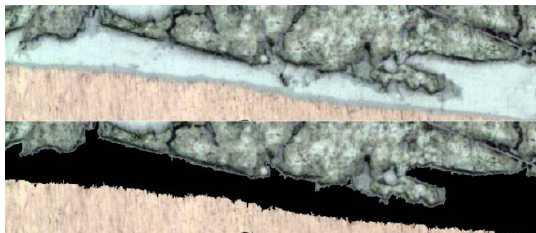
Figure 1. The schematic diagram of the lap Cu/Al brazed joint (unit: mm).